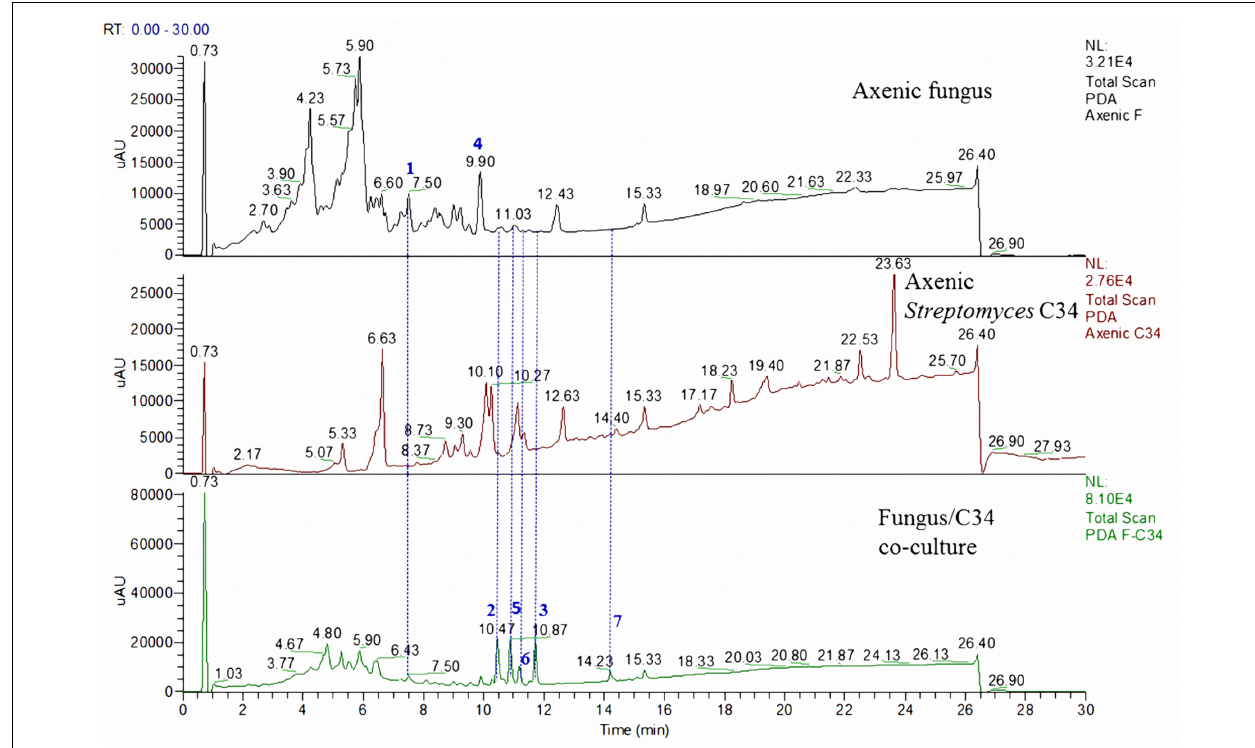
FIGURE 3 | LC comparison of the microbial co-culture of A. fumigatus MR2012 and S. leeuwenhoekii strain C34 on ISP2 medium.